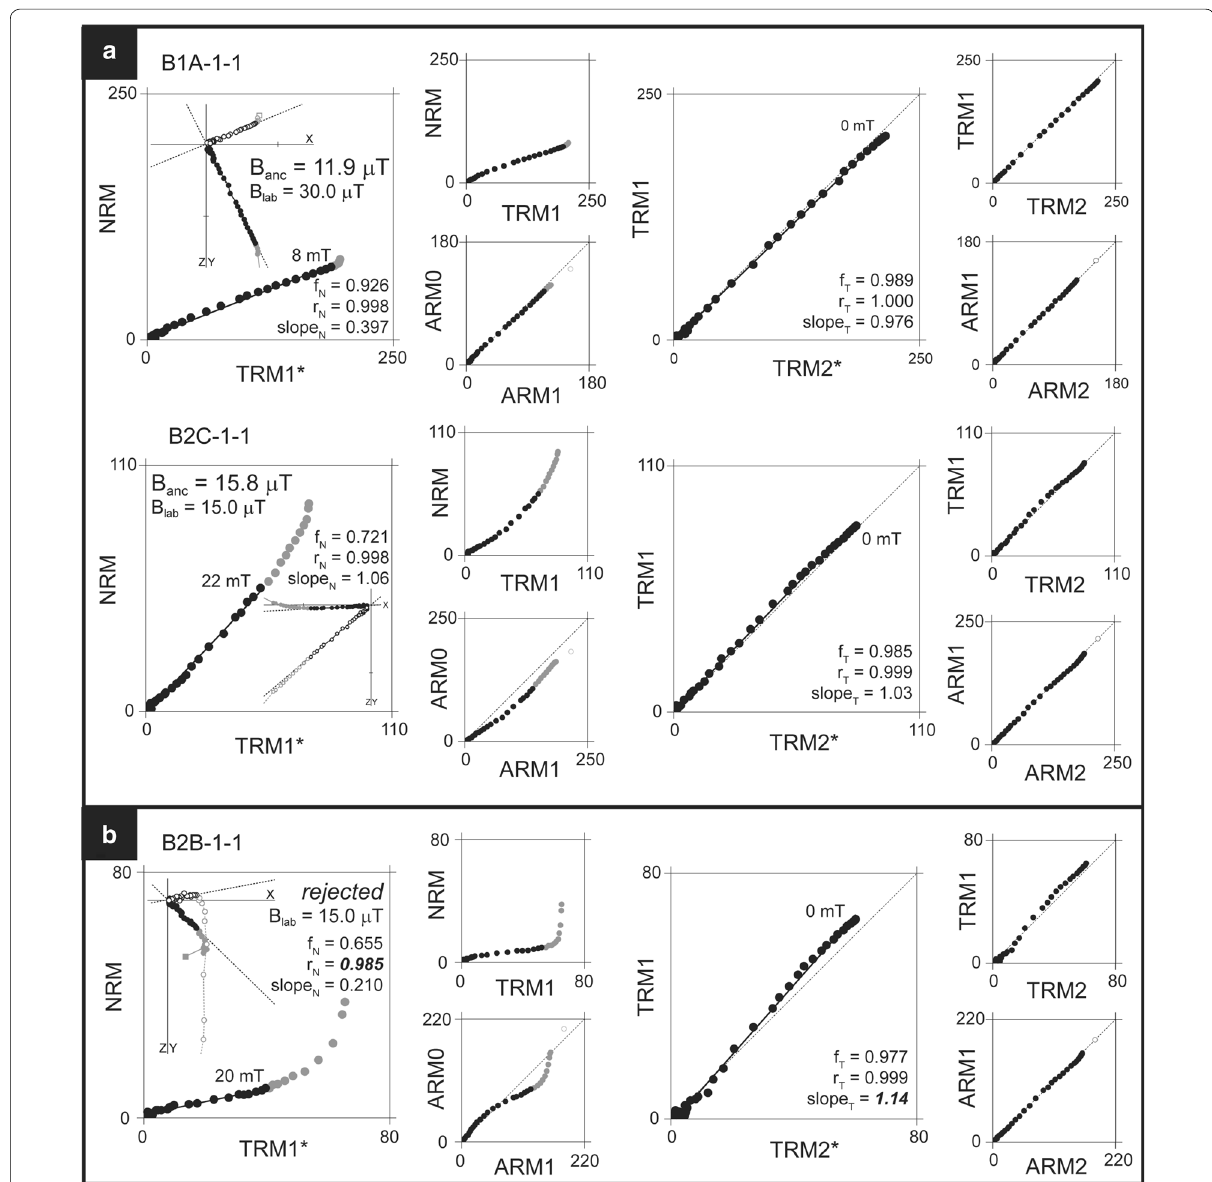
Fig. 4 Examples of results of the Tsunakawa–Shaw API experiments. a Two specimen‑level successful results in API determination. b A failed result. Three diagrams shown on the left‑hand (right‑hand) side are from a pair of the prior (first) laboratory heating and the first (second) laboratory heating procedures, where black symbols show selected intervals of data for determining the linear segments. Inset of a Zijderveld diagram on each NRM versus TRM1* diagram shows the AF demagnetization result of NRM, where filled (open) symbols indicate projection onto the horizontal (vertical)